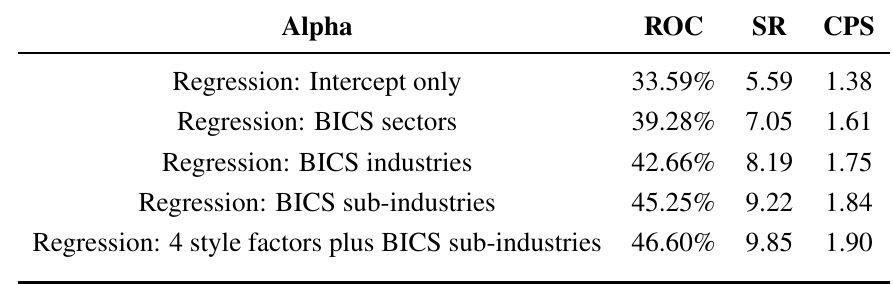
Table 1. Simulation results for the 5 alphas via regression without bounds discussed in Section 2.5.3.